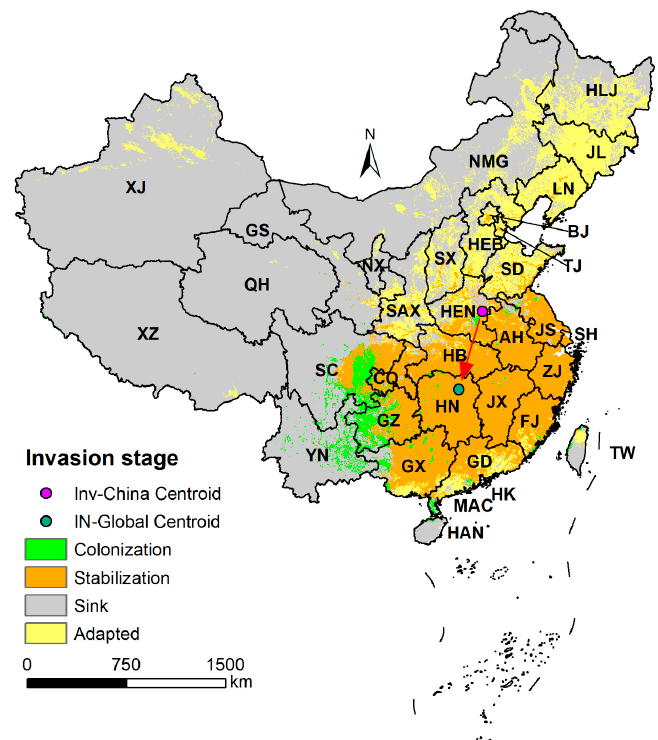
Figure 4. Observed occurrences of Ambrosia artemisiifolia at di ff erent invasion stages based on global (IN-Global) and regional (Inv-China) model predictions and mapped areas showing the potential (hypothesized) for population stabilization, adaptation, colonization, sink, and centroid transfer. The abbreviated name of each province is the same as in Figure